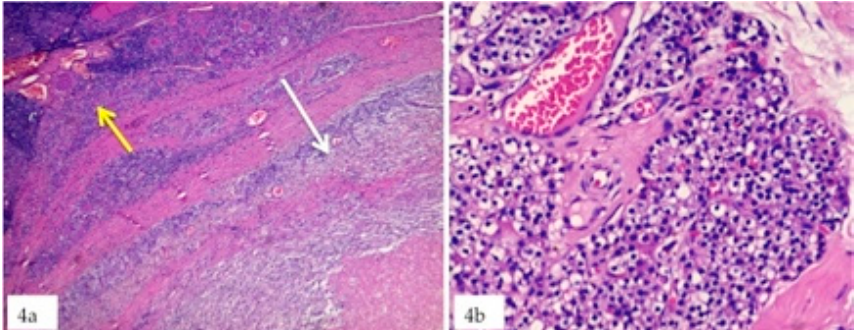
Figure 4. ( a ) Thyroid gland with Hashimoto thyroiditis (yellow arrow) and hyperplasia of an intra-thyroidal Parathyroid (withe arrow); ( b ), 40× magnification showing parathyroid gland hyperplasia with clear and chief aspects of the cells.